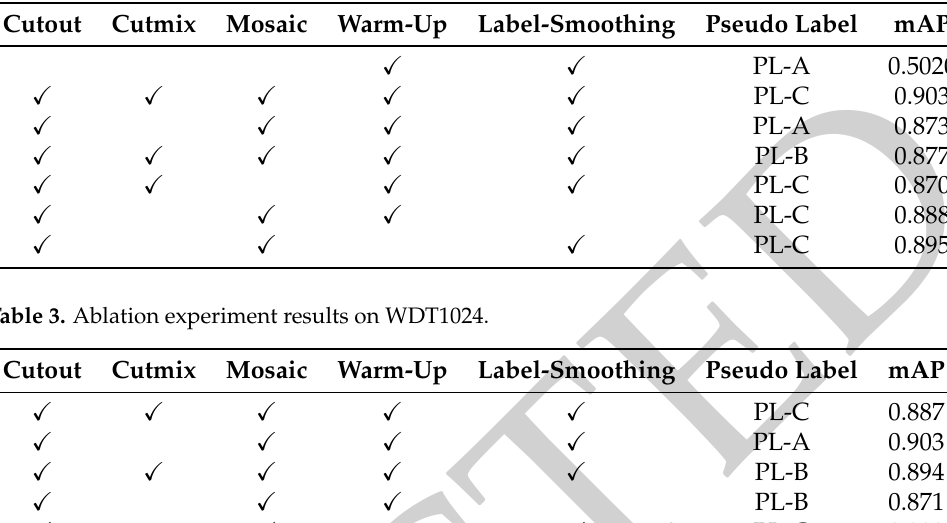
Table 2. Ablation experiment results on WDT512.